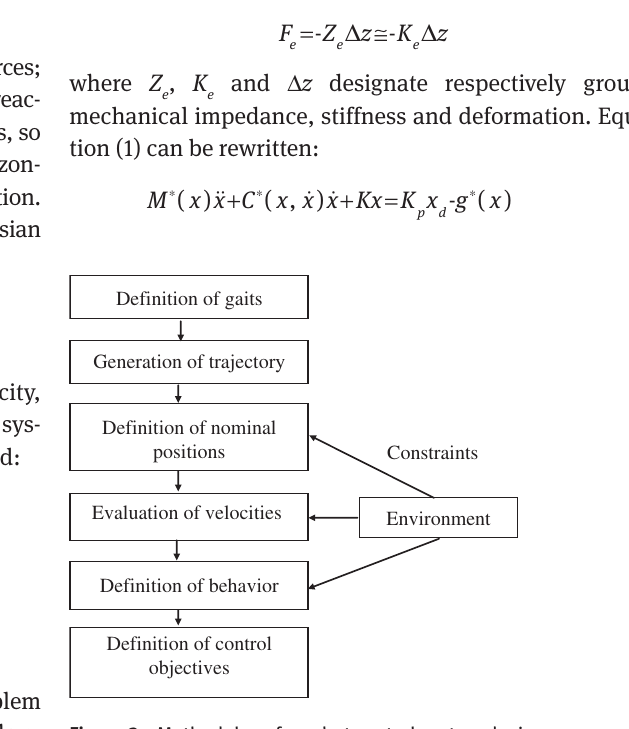
Figure 3: Methodology for robot control system